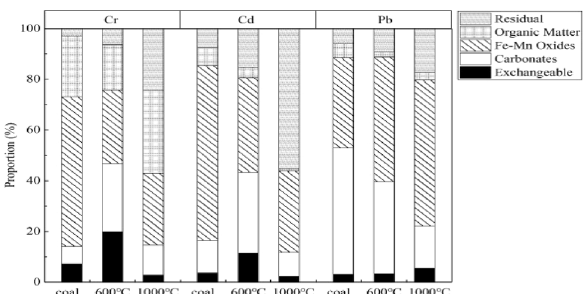
Fig. 4 Proportions of different forms of Cr, Cd, and Pb in the raw stone coal and its combustion ash generated at 600 (cid:3) C and 1000